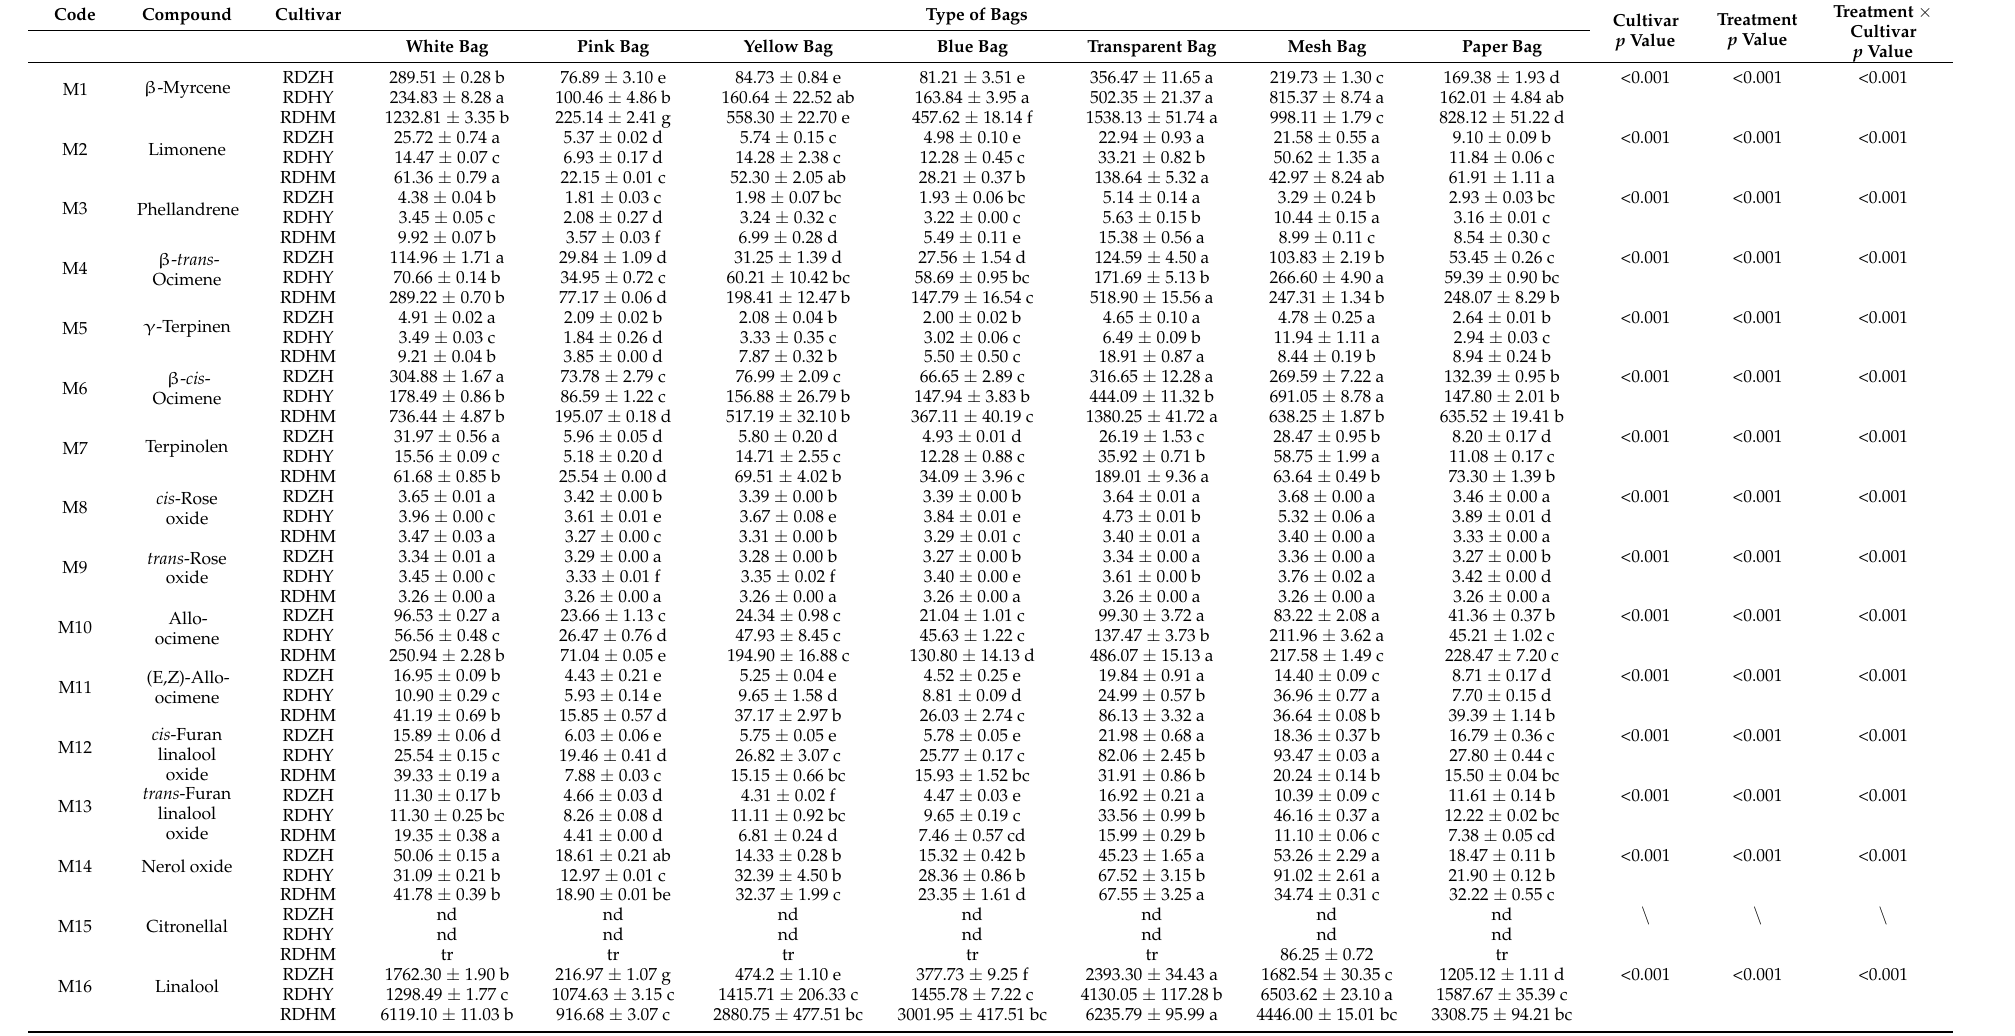
Table 2. Effects of fruit bagging treatment with different types of bags on monoterpene contents in three table grape cultivars ( µ g · L − 1